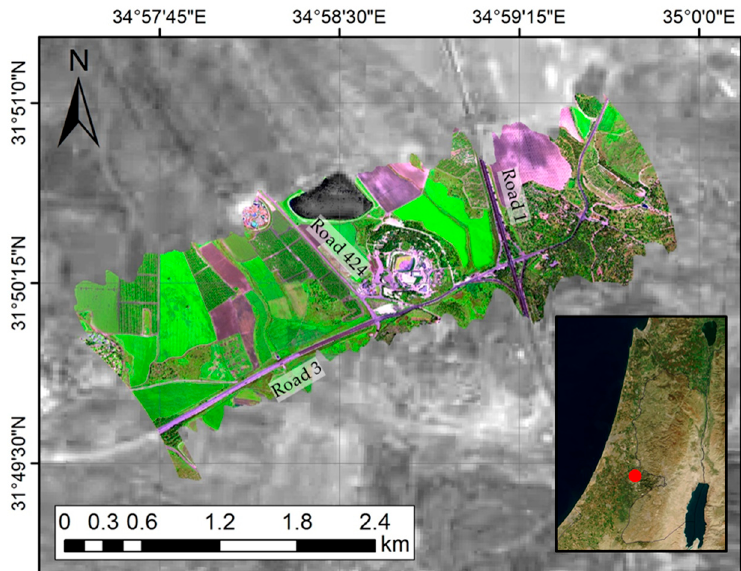
Figure 1. Location of the study area in central Israel with a true color image from the AisaFenix 1K hyperspectral sensor, and background greyscale image from sentinel ‐ 2 (Copernicus Sentinel Data 2017). Overview satellite image from MODIS (Rapid Response Team, NASA/GSFC).